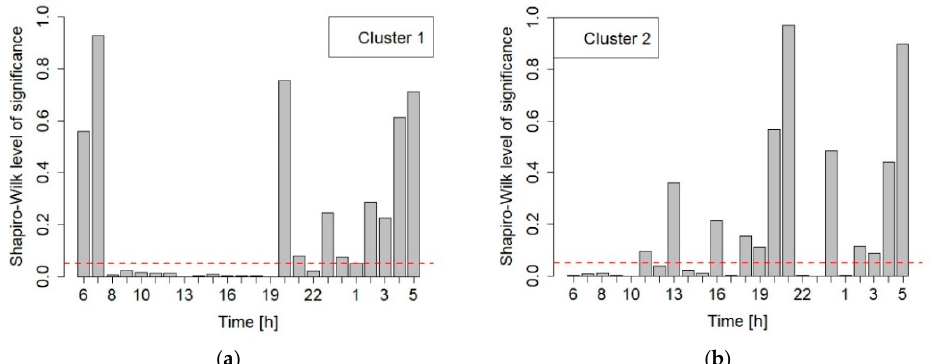
Figure 3. Shapiro–Wilk results for the normal distribution test of δ ik for Cluster 1 ( a ) and Cluster 2 ( b ) The red line indicates the threshold at the α = 0.05 significance level.